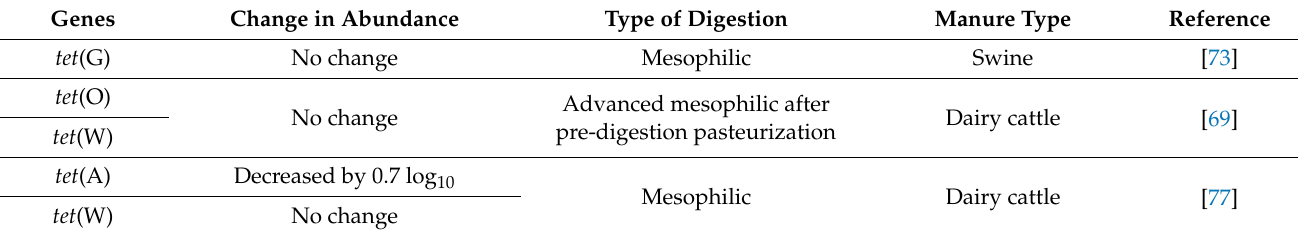
Table 3. Fate of tetracycline resistance genes during anaerobic digestion of animal